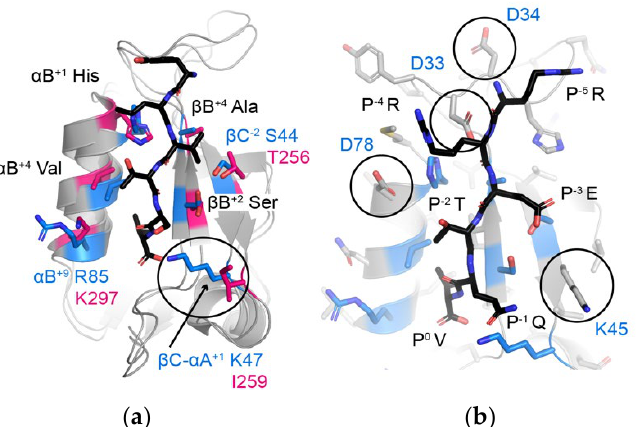
Figure 7. ( a ) Comparison of the peptide-binding clefts of A9UPE9 PDZ (marine) and DLG1-1 (pink, PDB ID 3RL7). DLG1-1 is bound to the peptide matching the C-terminal sequence of the adenomatous polyposis coli (APC) tumor suppressor protein (sequence: YLVTSV) [69]. Peptide-binding cleft residues are shown as side chain sticks, colored by heteroatom (N = blue, O = red) and labeled, where black text indicates shared residues and blue/pink text indicates differences. The β C- α A +1 residue, which influences P − 1 selectivity, is indicated with a black circle. ( b ) Additional residues in A9UPE9 that may influence peptide preferences include D33, D34, K45, and/or D78, which are labeled and highlighted with circles. All side chains are shown as gray sticks and colored by heteroatom, with peptide-binding cleft residues used in the DAMM program colored as in ( a ). The HPV18 E6 peptide (sequence: RRETQV) from PDB ID 2OQS is shown as reference and labeled.